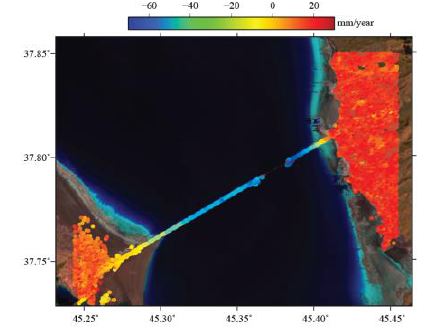
Figure 3. LOS deformation velocity map derived from ENVISAT (Track 92) in the time period of 2007-2010.